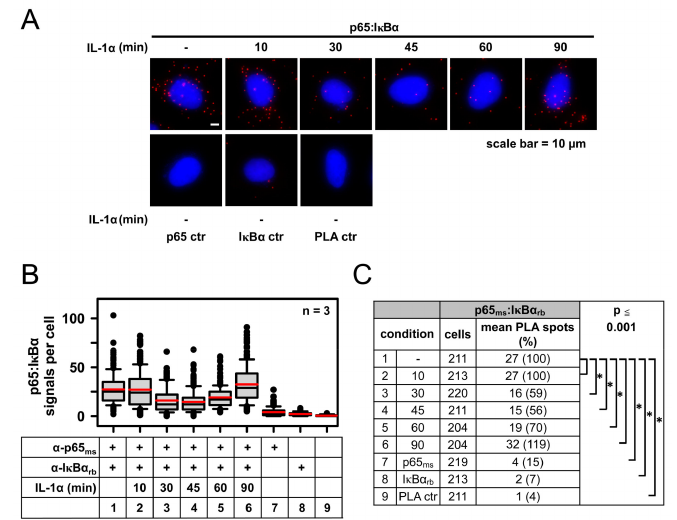
Figure 2. Sensitivity of PLA-based detection of p65 / I κ B α heterodimers as revealed by the analysis of IL-1 α -triggered kinetic changes in complex formation. HeLa cells were left untreated or treated with IL-1 α (10 ng / mL) for di ff erent time points as indicated. Subsequently cells were fixed and analyzed by PLA using the anti-p65 (F-6) and anti-I κ B α (E130) antibodies. As an internal control, antibodies were omitted or used individually. Nuclear DNA was stained with Hoechst 33342. ( A ) Representative merged images are displayed. ( B , C ) Data from three independent experiments were pooled. Evaluation and statistical analyses were performed as described for Figure 1. Distribution of PLA signals is shown in ( B ) and the summary and statistics of all relevant data are depicted in ( C